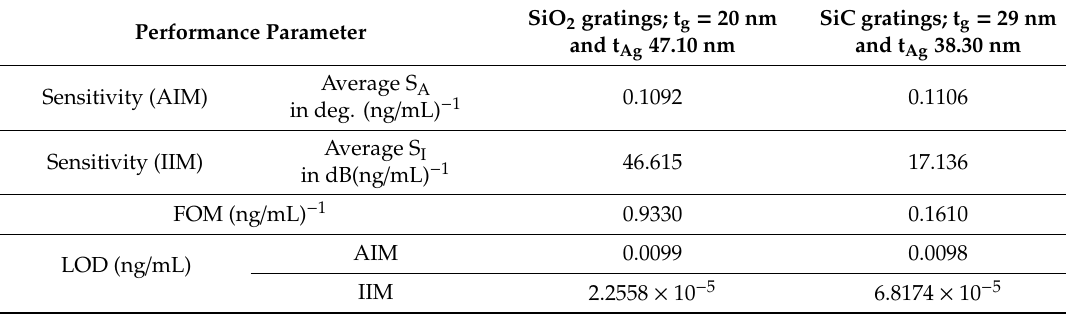
Figure 5. Figure of merit (FOM) variation with different concentration of cortisol (solution of cortisol-conjugated BSA) for SiO 2 and SiC grating based configurations. The reference sample C c = 0.36 ng / mL. Here, d 1 / d = 0.5, t Ag = 47.10 nm (for SiO 2 ) and t Ag = 38.30 nm (for SiC) and λ = 830 nm. Table 3. Summary of performance parameters for angular interrogation mode (AIM; FOM, S A and LOD) and intensity interrogation method (IIM; S I and LOD).